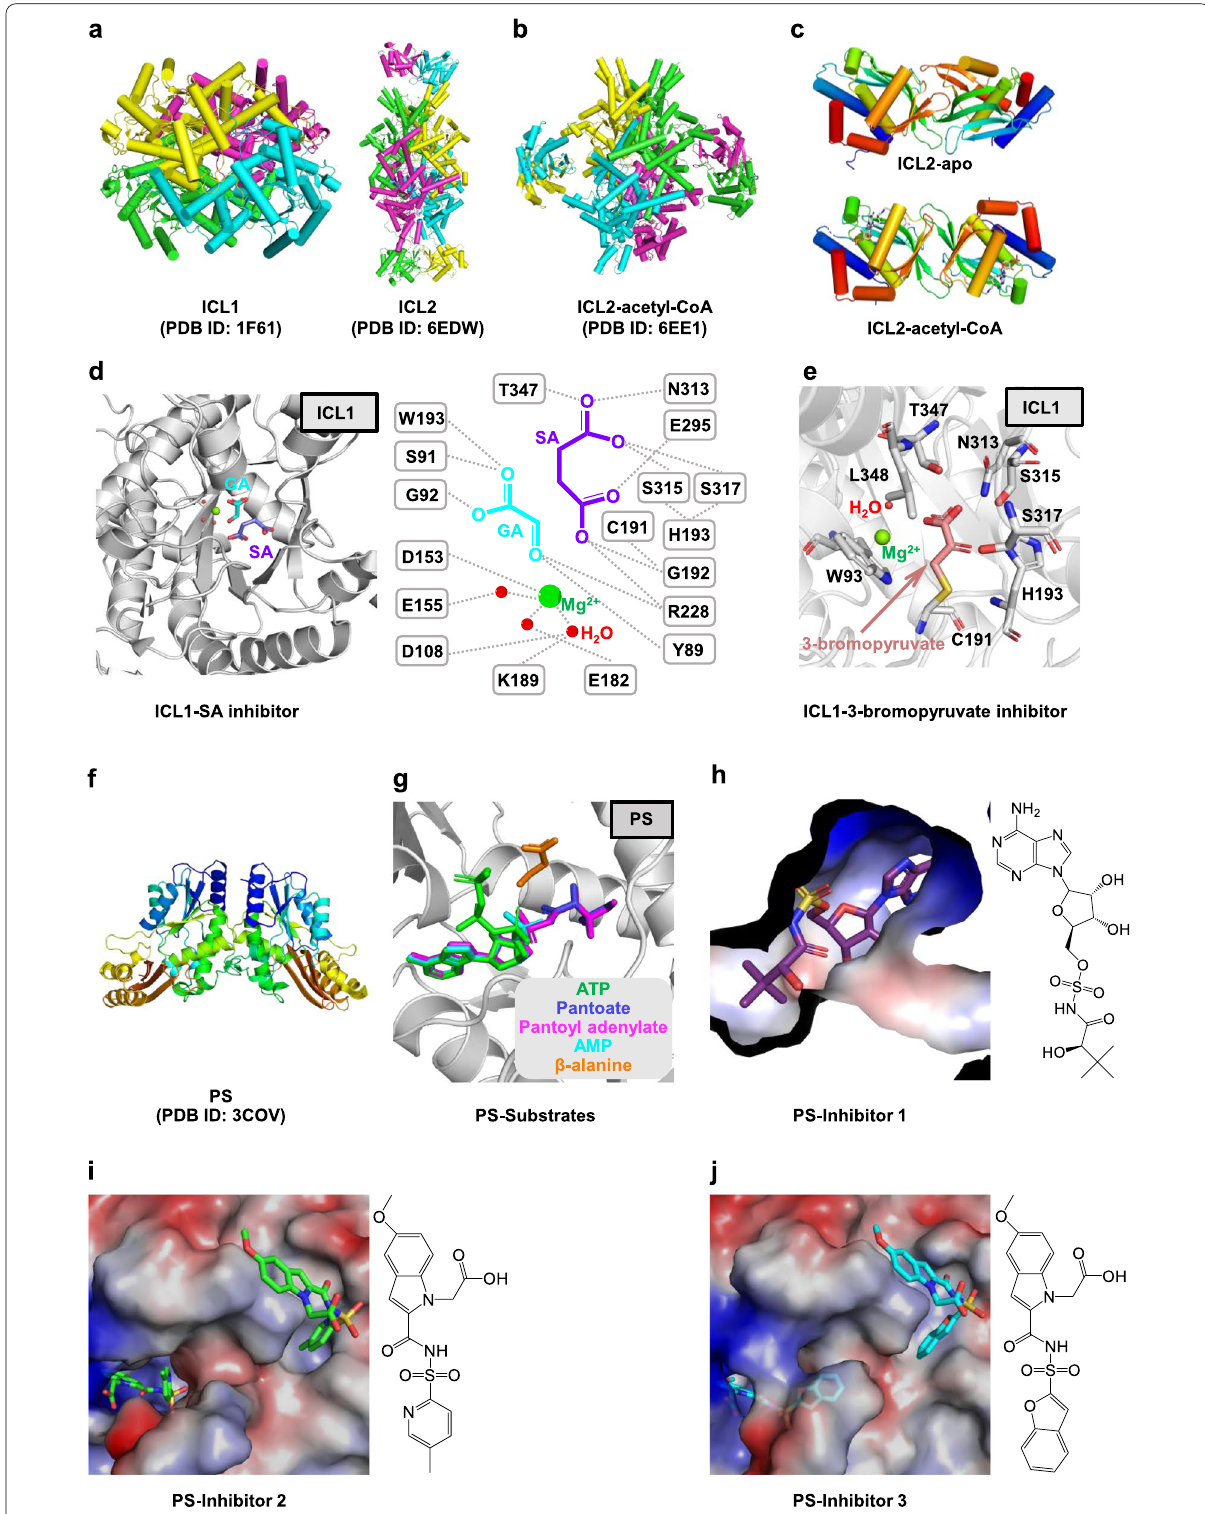
Fig. 4 (See legend on previous